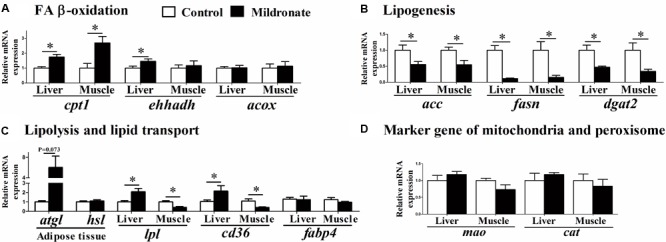
The effect of the dietary mildronate on the mRNA expression of lipid metabolism. (A) FA β-oxidation related genes; (B) lipogenesis related genes; (C) lipolysis and lipid transport related genes; (D) marker gene of mitochondria and peroxisome. All values are means ± SEM (n = 6). Values with ∗ and ∗∗ statistically differ at P < 0.05, and P < 0.01, respectively. cpt1, carnitine palmitoyltransferase 1; ehhadh, enoyl-CoA, hydratase/3-hydroxyacyl CoA dehydrogenase; acox, acyl-CoA oxidase; acc, acetyl-CoA carboxylase; fasn, fatty acid synthase; dgat2, diacylglycerol O-acyltransferase 2; lpl, lipoprotein lipase; atgl, adipose triglyceride lipase; hsl, hormone-sensitive lipase; fabp4, fatty acid binding protein 4; cd36 (fatp), fatty acid transport protein; mao, monoamine oxidase; cat, catalase.